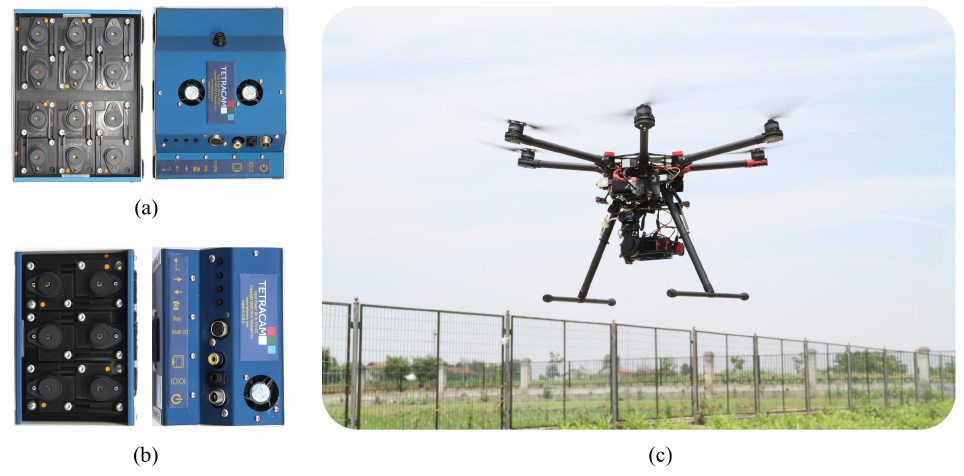
Figure 3. The illustration of ( a ) mini-MCA 12, ( b ) mini-MCA 6, and ( c )